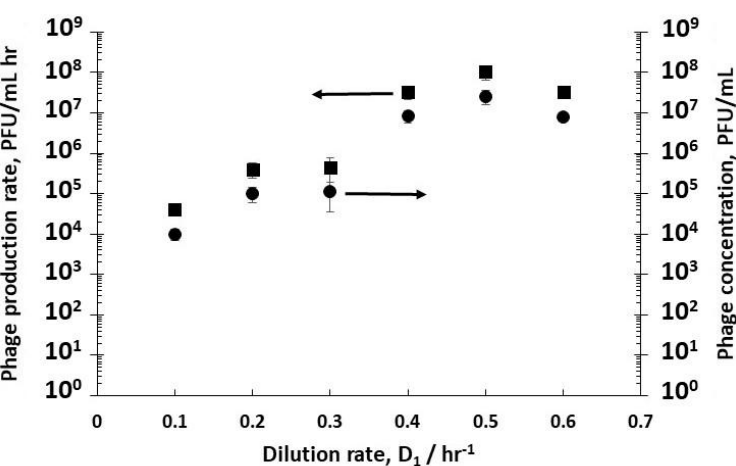
Figure 3. Phage productivity ( ■ ) in reactor 2 (R2) as a function of the dilution rate (D 1 ) in reactor 1 (R1). The dilution rate in R2 (D 2 ) was kept constant at a set value of 4 hr − 1 . The filled circles (●) show the concentration of phages (PFU/ml) in R2 at steady-state operation. Error bars represent one standard deviation.